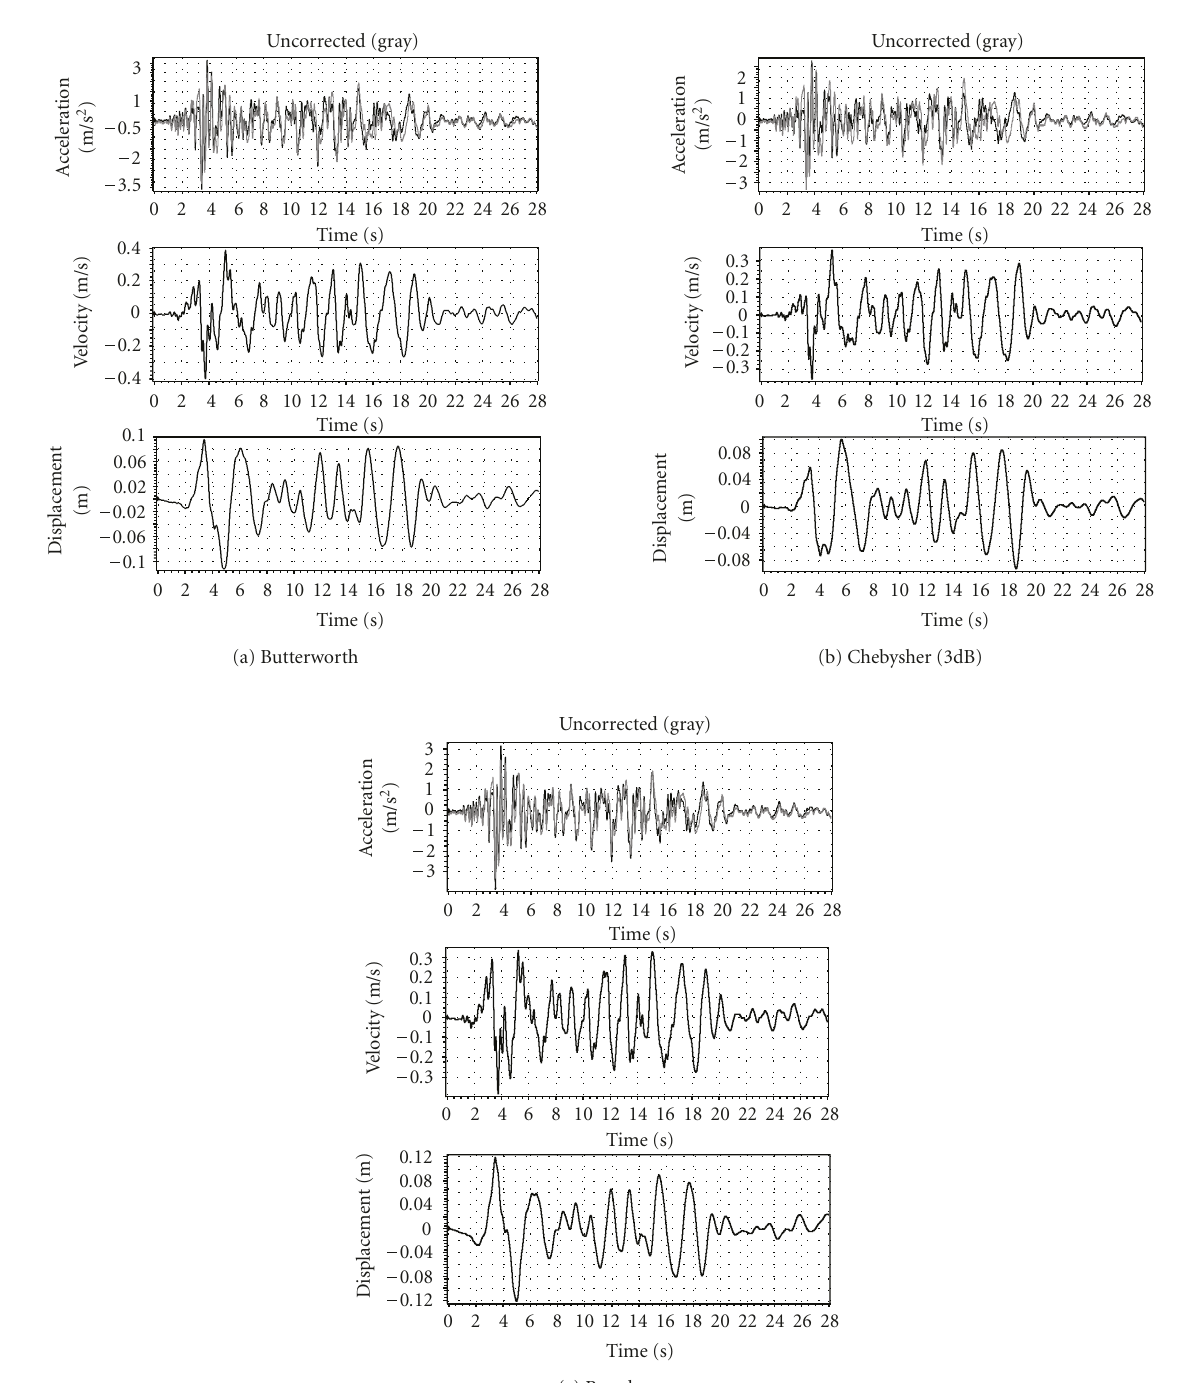
Figure 1: Corrected Dinar acceleration, velocity, and displacement (EW component) using bandpass filter: N = 4, f p 1 = 0 . 2Hz, f p 2 = 20Hz.